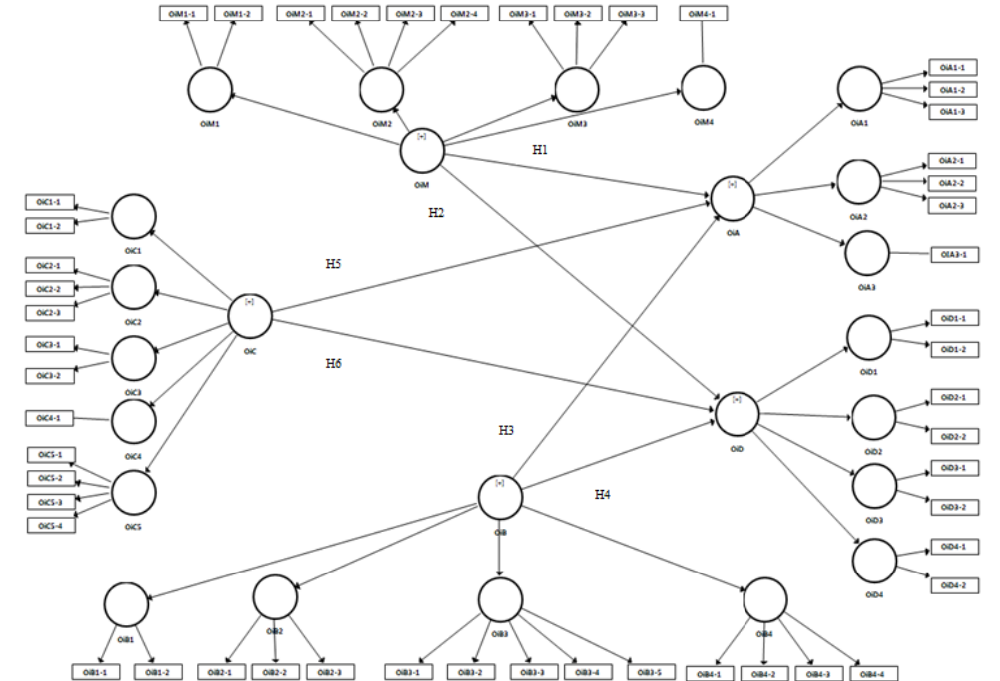
Figure 1. The research model and hypotheses.